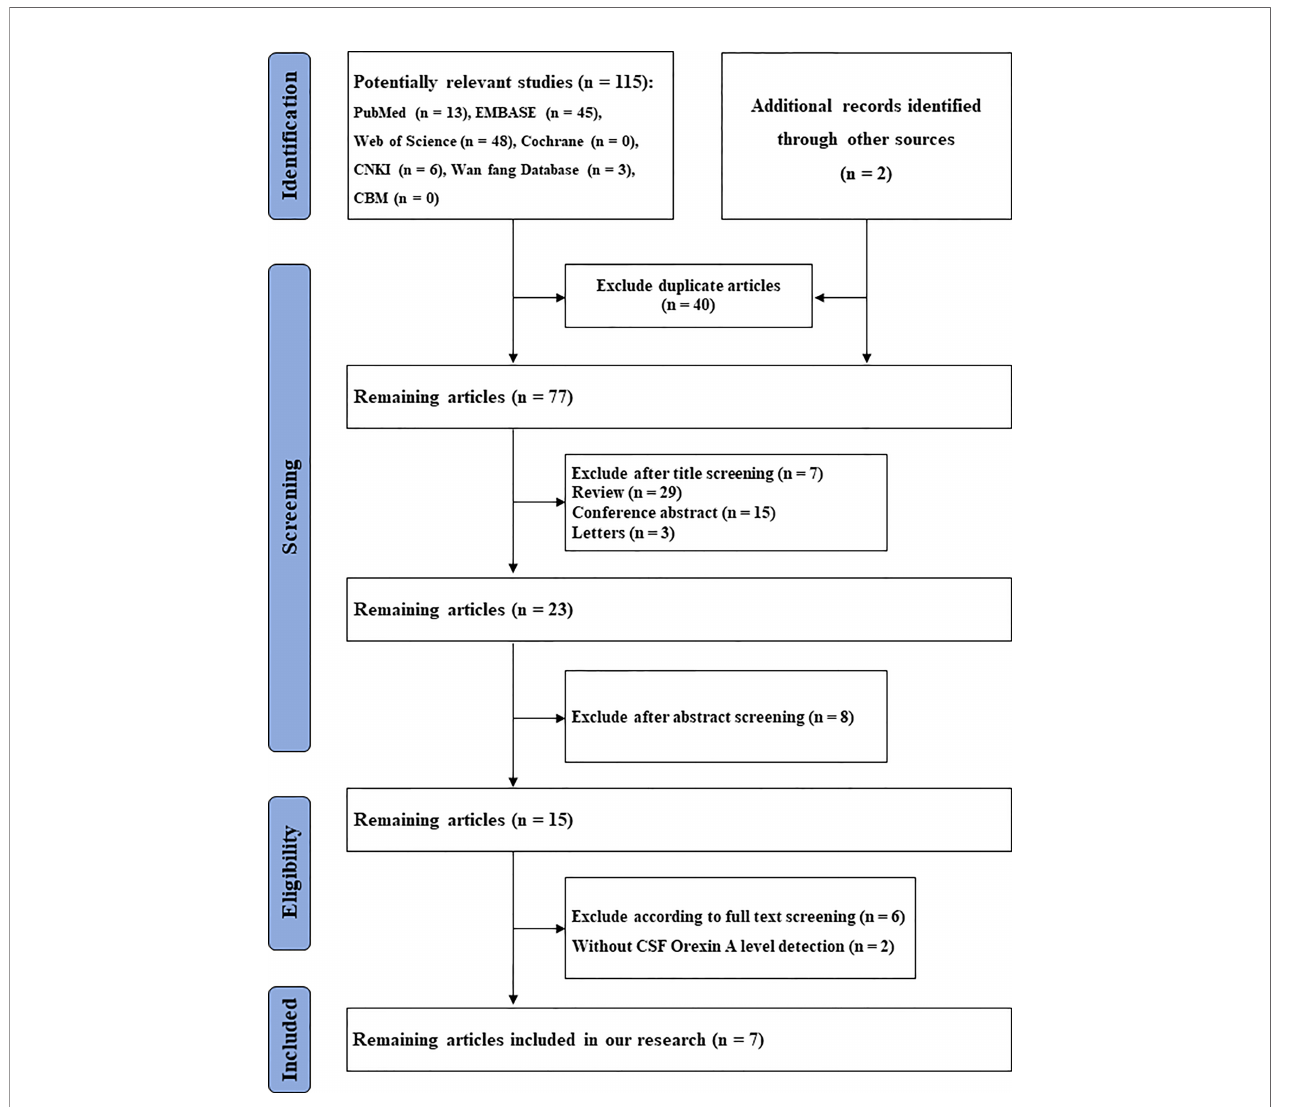
FIGURE 1 | Flowchart of study selection. CSF, cerebrospinal fl